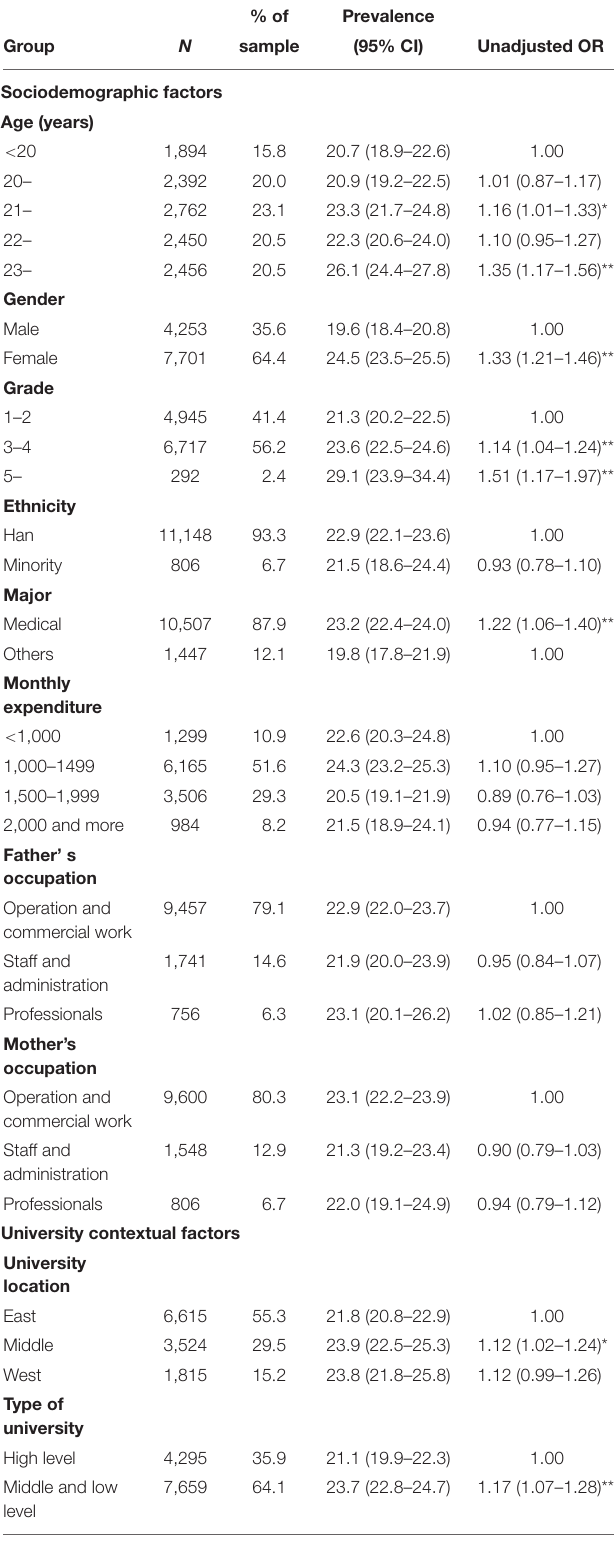
TABLE 1 | Sociodemographic characteristics and stress status of sample and mental disorder prevalence ( n = 11,954). %